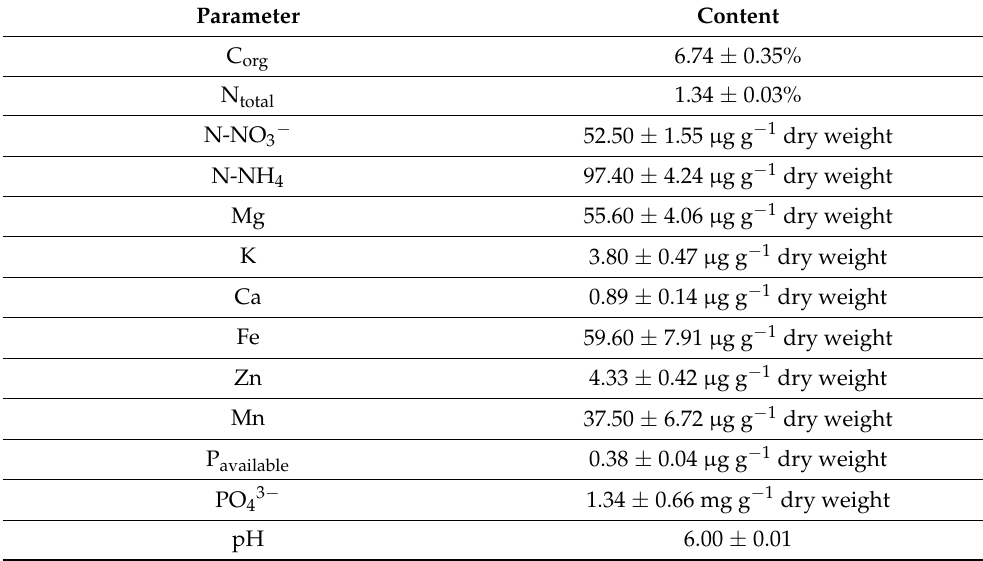
Table 1. Soil characteristics.